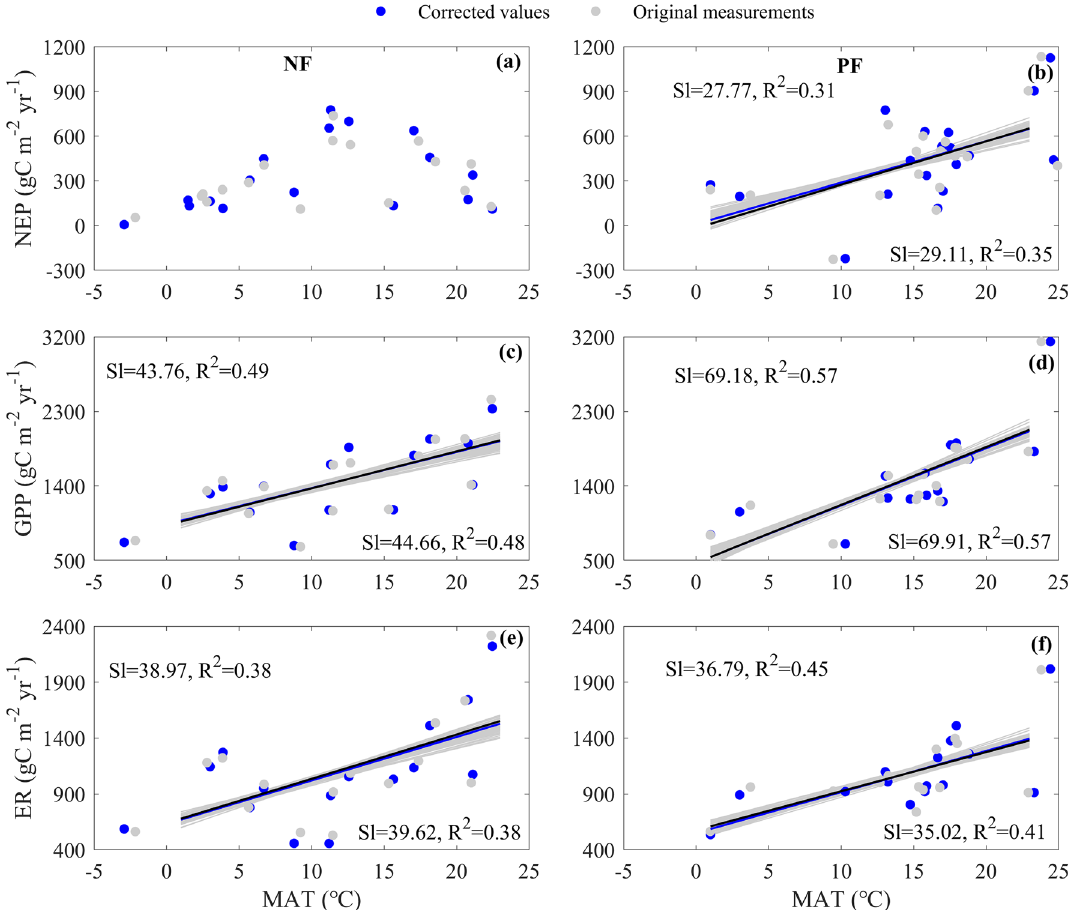
Figure 4. The effects of mean annual air temperature (MAT) on the spatial variations of carbon fluxes over Chinese naturally regenerating forests (NF) and planted forests (PF). The carbon fluxes include net ecosystem productivity (NEP, a , b ), gross primary productivity (GPP, c , d ), and ecosystem respiration (ER, e , f ). Each panel is drawn with the corrected values (blue points) and original measurements (grey points), respectively. The blue and black lines represent the regression lines calculated from the corrected values and original measurements, respectively, with their regression statistics listed in blue and black letters. Only the regression slope (Sl) and R 2 of each regression are listed. The grey lines represent the regressions between carbon fluxes added by random errors and latitude. Only significant (p < 0.05) regression lines are drew in each